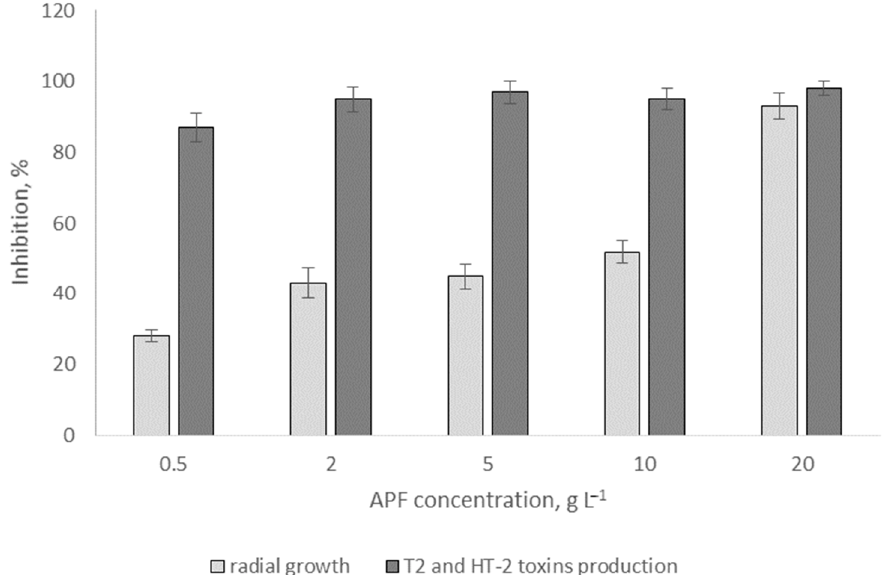
Figure 4. Inhibition of radial growth and mycotoxin production of F. oxysporum in the presence of APF produced by B. mojavensis P1709 in agar medium at different concentrations. The Wilcoxon signed rank test was used to determine statistically significant differences ( p < 0.05); the results of determination are presented in Supplementary Material.